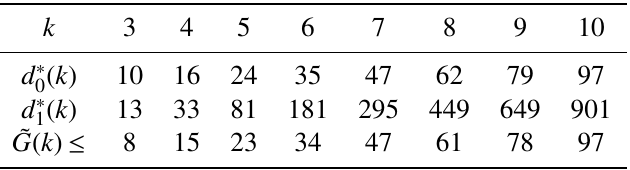
( k ) in Theorem 1, the corresponding values d ∗ 0